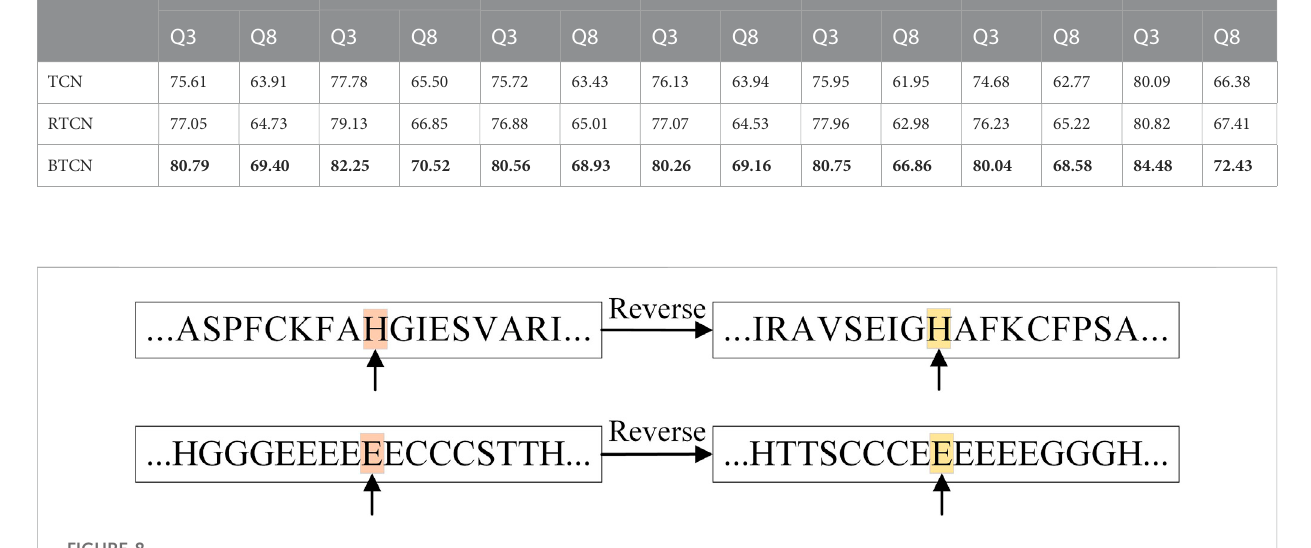
TABLE 2 Comparison of Q3 and Q8 accuracy of three models on seven datasets. Bold indicates the best performance. Models